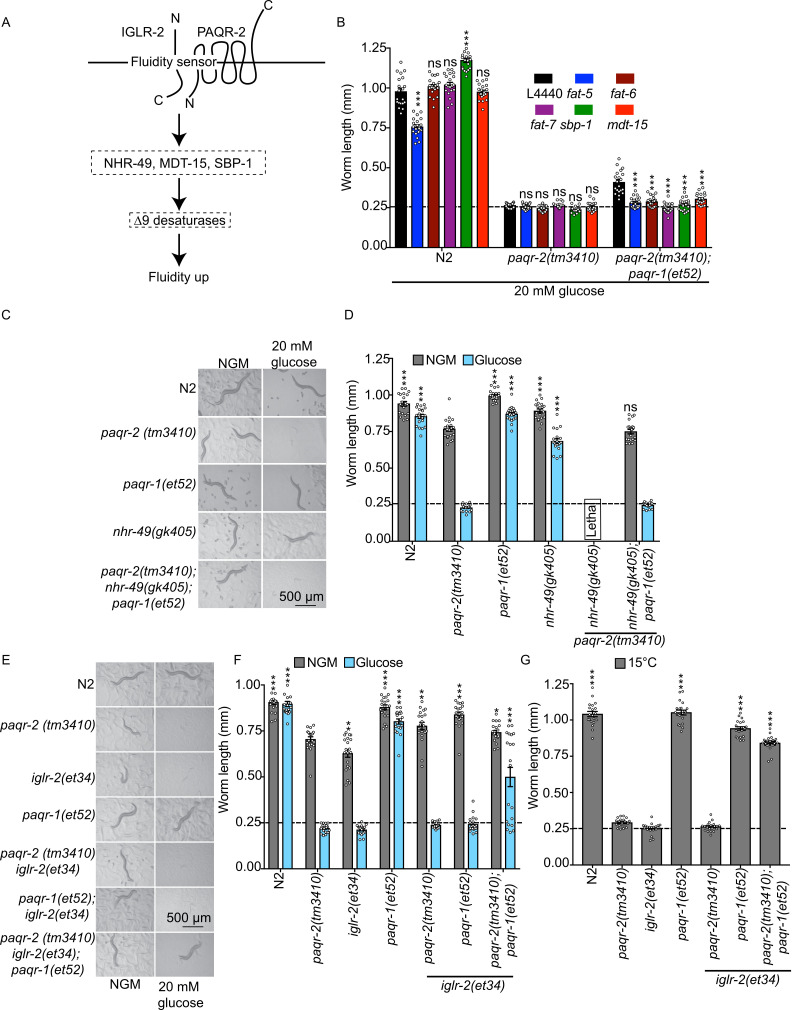
The gof paqr-1(et52) allele acts via the same pathway as paqr-2 but independently from iglr-2.(A) Simplified PAQR-2/IGLR-2 membrane homeostasis pathway. (B) Length of worms placed as L1s on the indicated media/RNAi treatment and measured 72 hours later. Note that the ability of paqr-1(et52) to suppress the poor growth defect of the null paqr-2(tm3410) mutant is dependent on the desaturases fat-5, -6, and -7, as well as the sbp-1 and mdt-15 transcription factors. Note also that these RNAi experiments are performed using the HT115 E. coli strain, which in itself is poorly tolerated by the paqr-2(tm3410) mutant[18]. (C-D) Images and length of worms placed as L1s on the indicated media and measured 72 hours later. Note that the gof paqr-1(et52) allele suppresses the lethality of the double null mutant paqr-2(tm3410); nhr-49(gk405) on normal growth media but not on plates containing 20 mM glucose. (E-F) Images and length of worms placed as L1s on the indicated media and measured 72 hours later. Note how the gof paqr-1(et52) allele suppresses the glucose intolerance of the double null mutant paqr-2(tm3410) iglr-2(et34) but not that of the single null mutant iglr-2(et34). (G) Length of worms placed as L1s on NGM media and measured after 144 hours cultivation at 15°C. Note how the gof paqr-1(et52) allele suppresses the growth intolerance of both the double null mutant paqr-2(tm3410) iglr-2(et34) and the single null mutant iglr-2(et34). The dashed lines in B, D, F and G indicate the approximate size of the L1 larvae at the start of the experiment. Significant differences compared to the paqr-2 genotype are indicated where: * p<0.05, **p<0.01 and ***p<0.001 (ns: not significant).